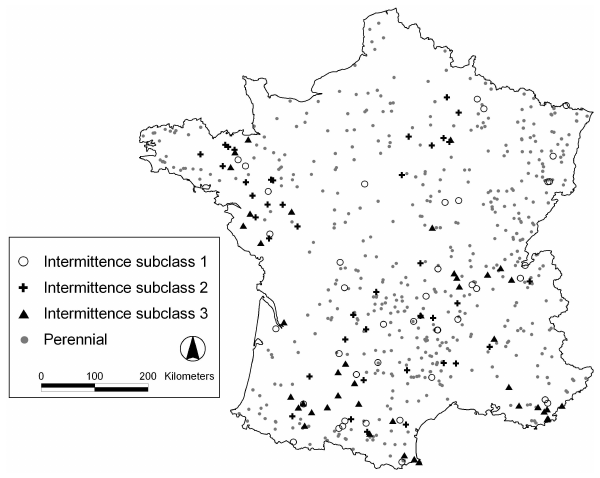
Fig. 2. Map of the location of the gauging stations used in this study. Stations on perennial segments are indicated by closed circles. Sta- tions on intermittent segments are classified into three intermittence subclasses (see text for class